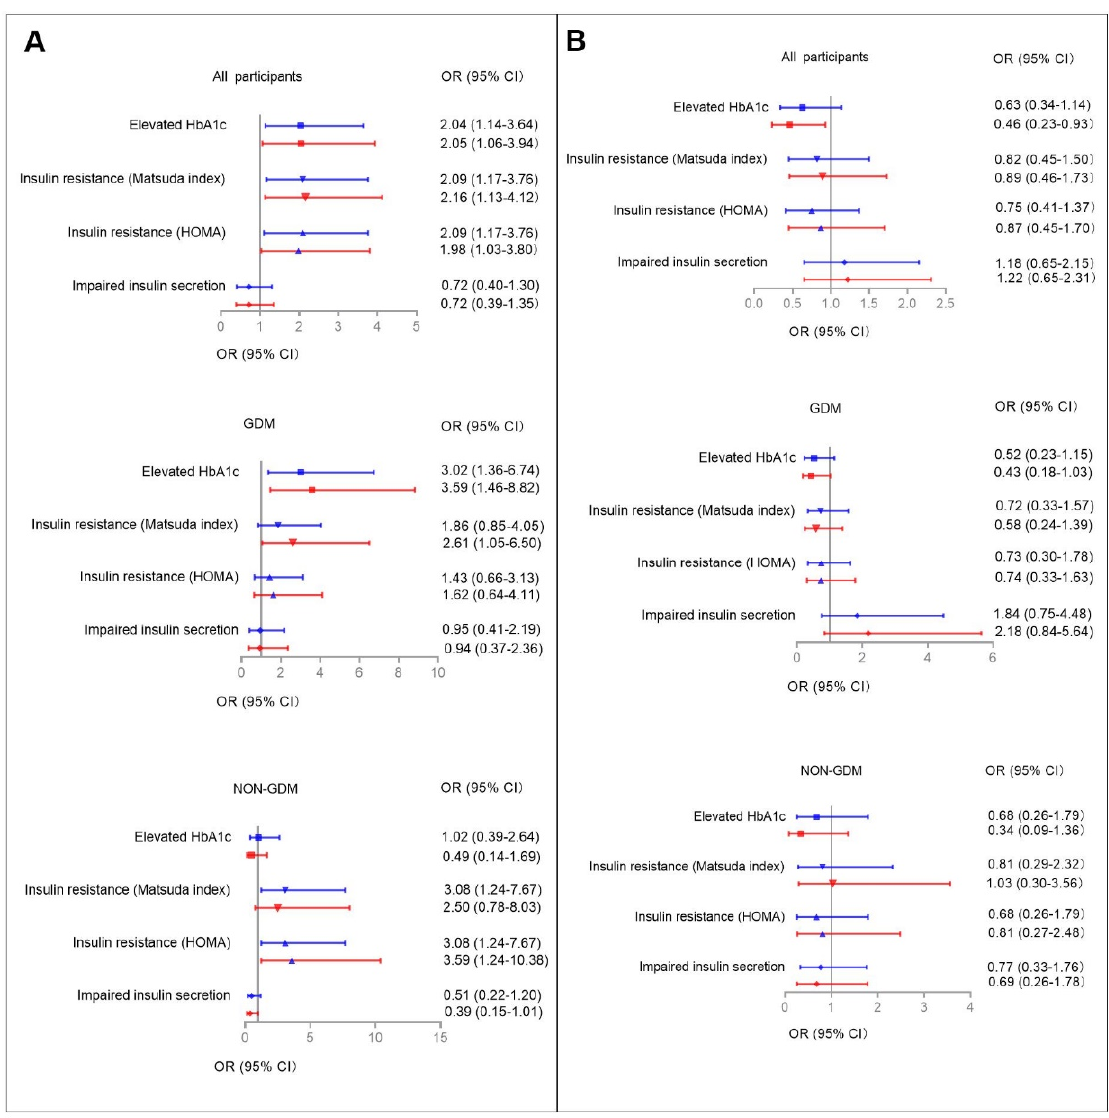
Figure 2. The associations between higher serum aspartame ( A ) and sucralose ( B ) levels with abnormal glucose metabolism during pregnancy. Higher serum aspartame and sucralose levels were defined as ≥0.0657 (nmol/L) and ≥0.4240 (nmol/L), respectively. Multiple logistic regression models were used to determine the associations between higher serum aspartame and sucralose levels with abnormal glucose metabolism during pregnancy among all participants, and among those with and without GDM, respectively. Adjusted cofactors included maternal age, family history of diabetes, maternal MAP at OGTT, pre-pregnancy BMI, and parity (0, 1+). Blue and red lines indicate ORs (95% CIs) before and after full adjustments, respectively. Reference: Women lower aspartame/sucralose levels among all participants, and those with and without GDM, respectively. Results were considered significant associations if the 95% CIs did not contain 0.